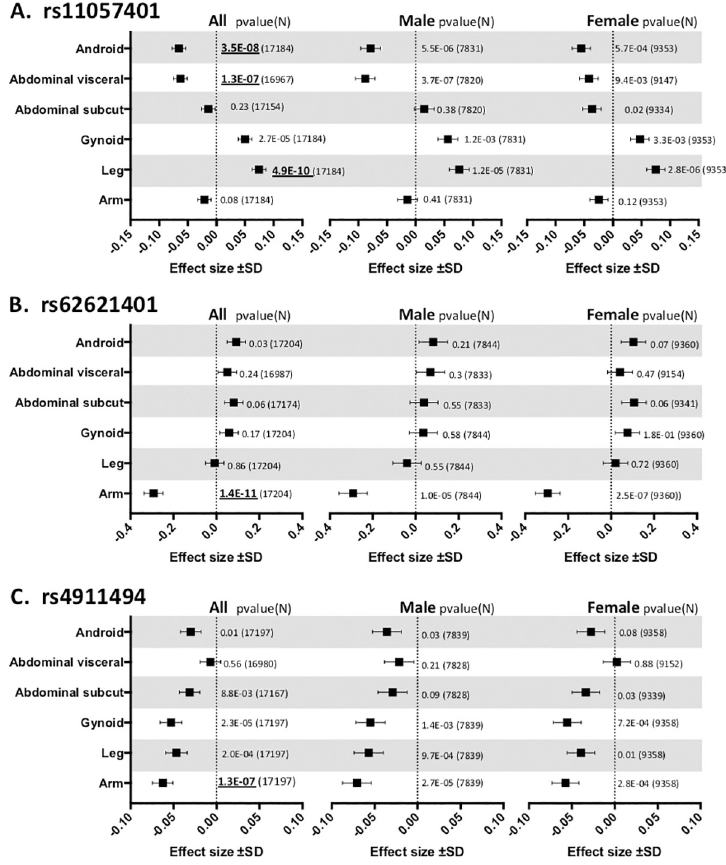
Fig 1. The effect size and direction of effect of meta-analysis findings. Effect size and direction of effect of the three exome-wide significant missense variants: A. rs11057401 in CCDC92 (EAF = 0.32), B. rs62621401 in SPATA20 (EAF = 0.016) and C. rs4911494 in UQCC1 (EAF = 0.62). Data is presented for the 6 DXA measures under investigation and is presented as the beta value ± SD. The meta-analysis significance level using an additive model for gender combined (All) as well as for gender stratified analysis, together with the N indicated to the right of the data in parentheses. DXA measures are Arm fat mass (Arm), Total android fat mass (Android), Subcutaneous android fat mass (Abdominal subcut), Visceral android fat mass (Abdominal visceral), Gluteal fat mass (Gynoid) and Leg fat mass (Leg). Exome-wide significant data (p < 2E -7 ) are in bold and underlined. a large haplotype block on chromosome 17 containing 8 missense variants across the SPPL2C , MAPT , KANSL1 genes and GDF5 S276A in LD with UQCC1 R51Q . The rs11057401 CCDC92 variant (EAF = 0.32) is predicted to cause a deleterious amino S70C acid change as assessed by predictSNP[13]. The minor allele of rs11057401 shows significant opposing effects on android, specifically visceral fat mass, and lower body fat, in the sex-com- bined additive model (total abdominal fat mass: β = -0.065, SE = 0.012, p = 3.5 × 10 − 8 ; visceral abdominal fat mass: β = -0.063, SE = 0.012, p = 1.3 × 10 − 7 ; leg fat mass: β = 0.075, SE = 0.020, p = 4.9 × 10 − 10 ) (Table 2). These data extend WHR associations reported by Justice, et al.[3] and Lotta et al .[11] at this locus. Lotta et al .[11] describe the contribution of leg fat mass; we here demonstrate an additional opposing effect specifically on abdominal visceral fat mass but not for abdominal subcutaneous fat mass, which would correspond to the already observed associ- ation with increased waist circumference but with the present analysis showing that the effect is confined to the intra-abdominal fat depot only. Found on chromosome 12q24, CCDC92 is ubiquitously expressed with highest levels in adipose tissue, brain and testes. It is a nuclear